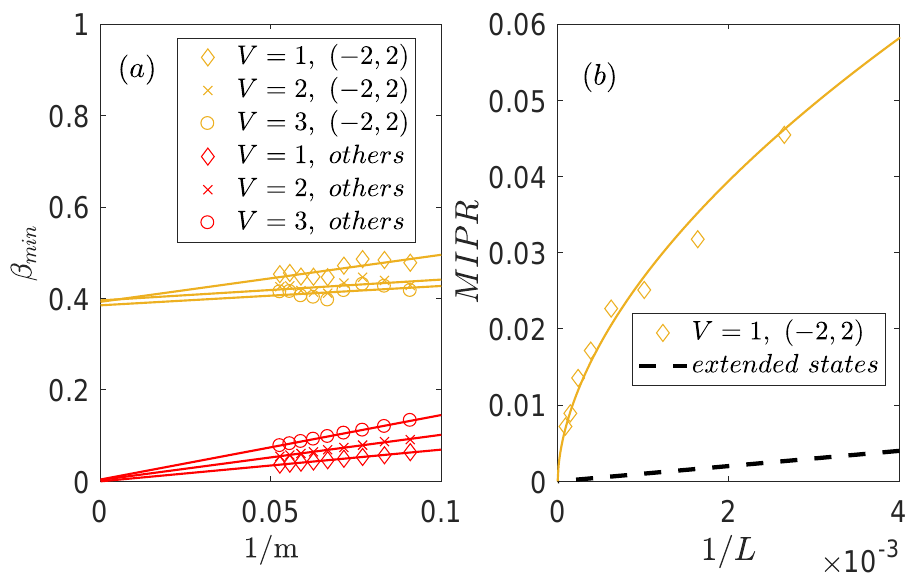
Figure 2: (a) Minimal scaling exponent β as a function of the inverse Fibonacci min index 1 / m for the various potential strengths V and a = 2. The brown markers cor- respond to the eigenenergies in the interval ( − 2,2 ) , and the red markers correspond to the other energies, i.e., outside ( − 2,2 ) . (b) Mean IPR (MIPR) versus the inverse system size 1 / L for states in the critical phase for V = 1 (brown markers). It shows the power law behaviour M I PR ∼ 1 / L 0.56 , clearly different from extended states (1 / L , shown as the dashed black line for